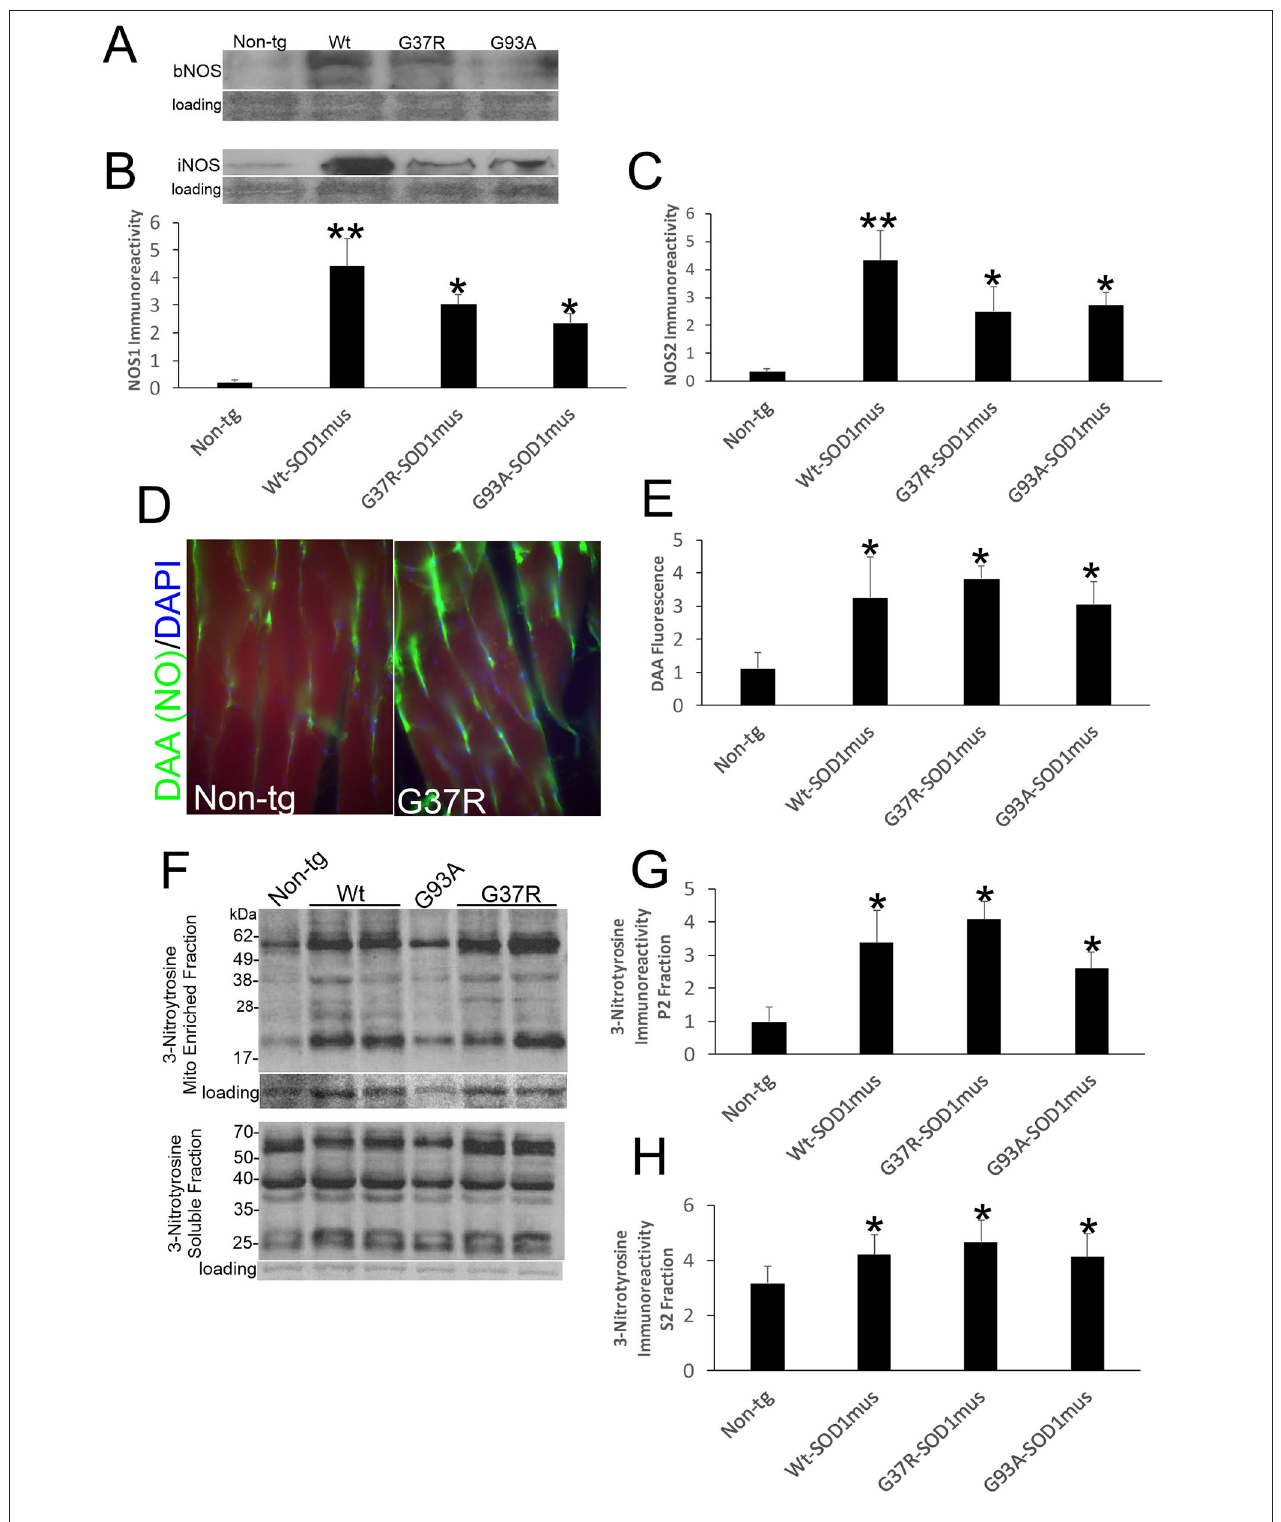
FIGURE 7 | Nitric oxide signaling is upregulated in skeletal muscle of hSOD1 mus mice. (A,B) Western blotting showed upregulation of NOS1 (bNOS) and NOS2 (iNOS) in hindleg of hSOD1 mus mice. Ponceau S stained membrane shows protein loading. (B) Graph for NOS1 immunodensity demonstrating significantly elevated levels